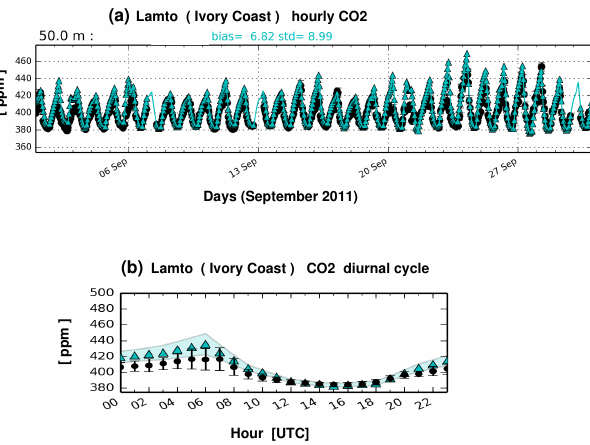
Figure 12. (a) Hourly mean dry molar fraction of CO 2 [ppm] and (b) its mean diurnal cycle at the ICOS site at Lamto (Ivory Coast) from measurements (dark circles) and hindcast (blue triangles) in September 2011. The standard deviation of observations and hind- cast are shown as black bars and blue shading respectively. The solid blue line in (a) shows the hourly values of the CO 2 hindcast even in the absence of observations and in (b) the mean diurnal cycle in the CO 2